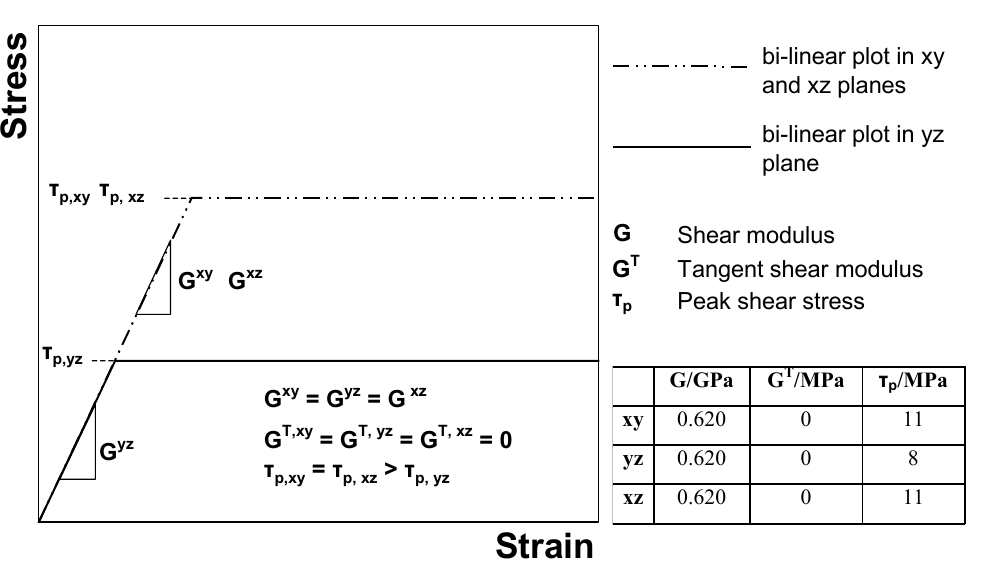
Figure 7. Bi-linear stress-strain approximations and related values for LVL in xy, yz and xz shear